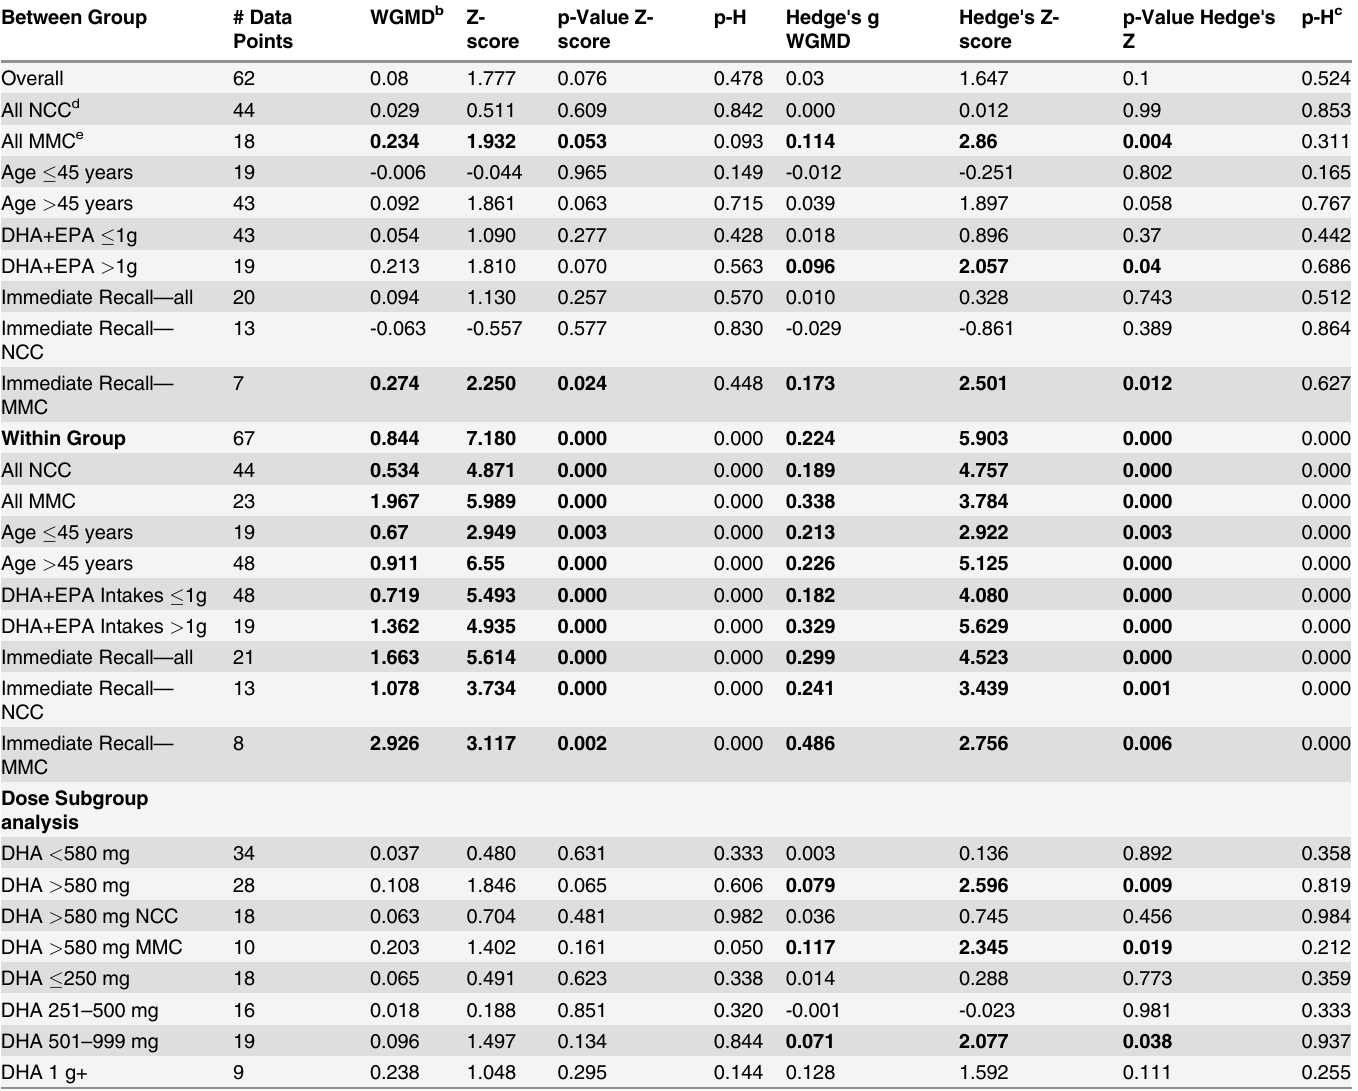
Table 2. Summary of DHA/EPA a Supplementation and Episodic Memory Outcomes in